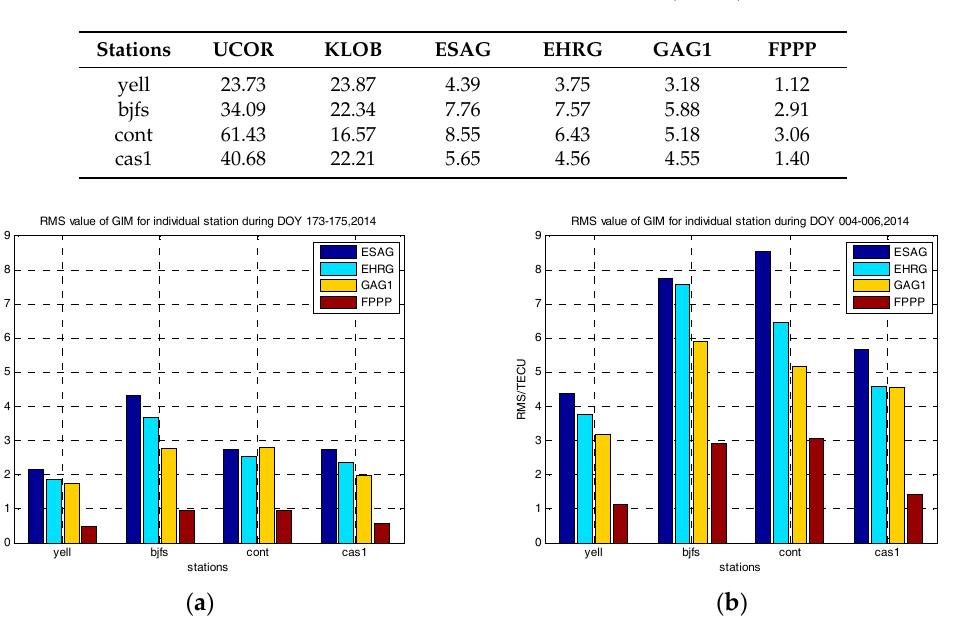
Table 7. The RMS of individual station for Case 2 (TECU).